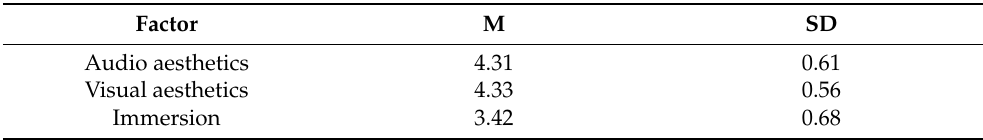
Figure 6. Participants’ responses to the System Usability Scale (SUS) questionnaire. Table 5. Descriptive statistics for the GUESS and immersion